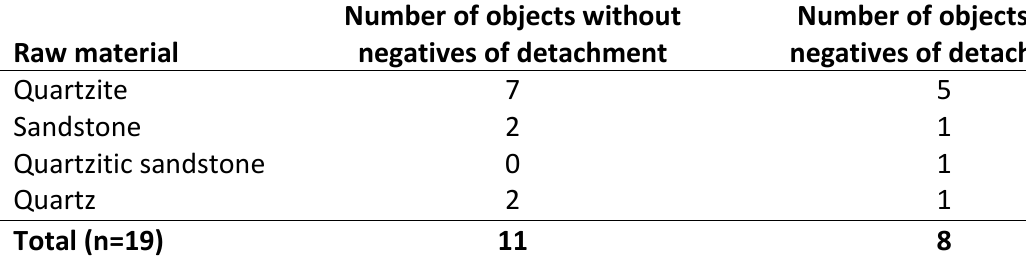
Table 6. Anvils from GH 3.